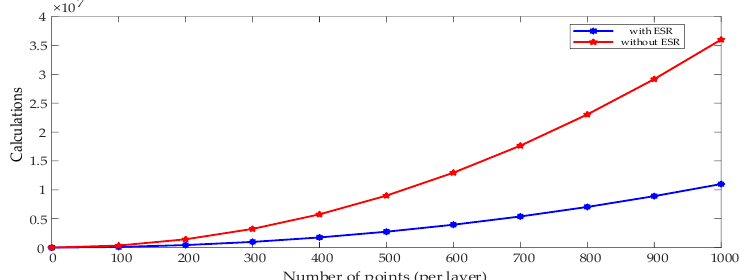
Figure 11. Calculations with respect to the number of points.